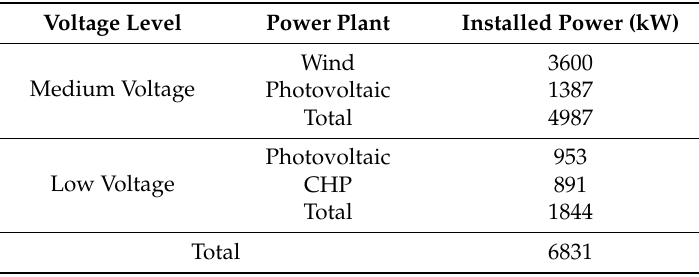
Table 2. Borkum power plant overview.